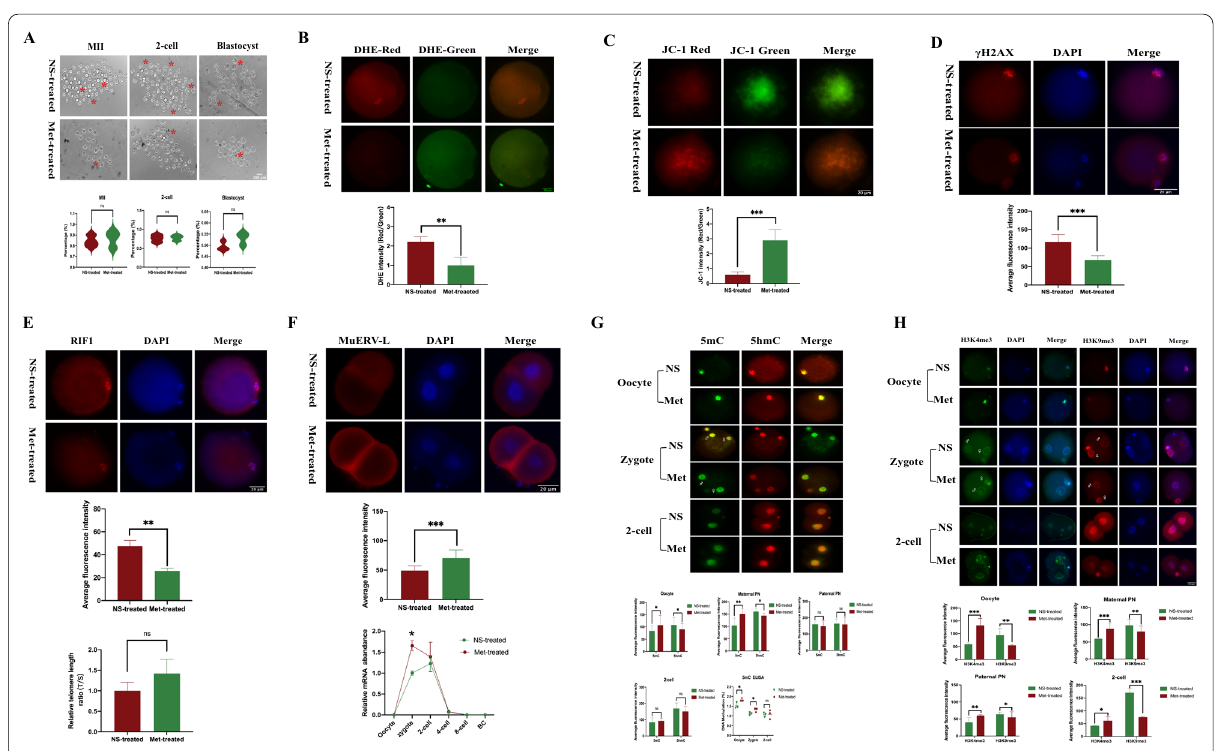
Fig. 4 Metformin alleviated the adverse effects of HFD on oocytes and preimplantation embryos. A Developmental status captures of the oocytes and embryos in the NS-treated and Met-treated groups. Red asterisks indicate abnormal oocytes and embryos. Bottom: Statistical results of developmental status (oocytes, n 121 for NS-treated group and n 109 for Met-treated group; 2-cell embryos, n 104 for NS-treated group and = = = n 92 for Met-treated group; blastocysts, n 54 for NS-treated group and n 51 for Met-treated group). B Reactive oxygen species (ROS) of MII = = = oocytes stained with dihydroethidium (DHE) probes in the NS-treated and Met-treated groups. The red fluorescence intensity represents the level of ROS. Bottom: The statistical results are shown. C Mitochondrial membrane potential (MMP) of MII oocytes stained by JC-1 in the NS-treated and Met-treated groups. The ratios of the red/green fluorescence intensity indicated the levels of MMP. and Bottom: The statistical results are shown. D Images of γ-H2AX staining in oocytes of the NS-treated and Met-treated groups. Bottom: The statistical results are shown. E The expression of RIF1 in oocytes of the NS-treated and Met-treated groups. Top: Representative IF images. Middle: Statistical analysis results from IF. Bottom: qPCR results of the relative telomere length (RTL) of the NS-treated and Met-treated oocytes. F The expression of MuERV-L gag in the 2-cell embryos of the NS-treated and Met-treated groups. Bottom: Statistical results from IF and qPCR. G IF images of 5mC and 5hmC enrichment during ZGA between the NS-treated and Met-treated groups. The statistical diagrams and the ELISA results of 5mC are shown at the bottom. H IF images of H3K4me3 and H3K27me3 enrichment during ZGA between the NS-treated and Met-treated groups. Throughout, n 20 in each group for IF analysis, and = n 3 in each group for qPCR analysis. Data are presented as means SD. P values are calculated by Student’s t test. * p < 0.05, ** p < 0.01, *** p < 0.001. = ± ns indicates not significant. Scale bars are shown in the lower right corner of the captures. NS-treated: normal saline-treated; Met-treated: metformin-treated. ♀ represents maternal pronuclear (PN). ♂ represents paternal